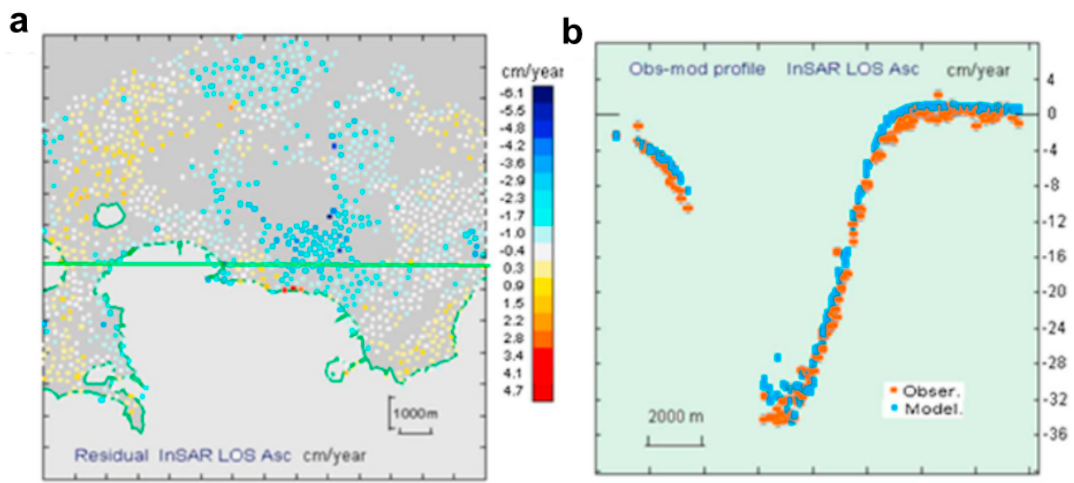
Figure 4. Some additional views of the LOS ascending data fit: ( a ) residual map and ( b ) WE central profile for observed-modeled comparison